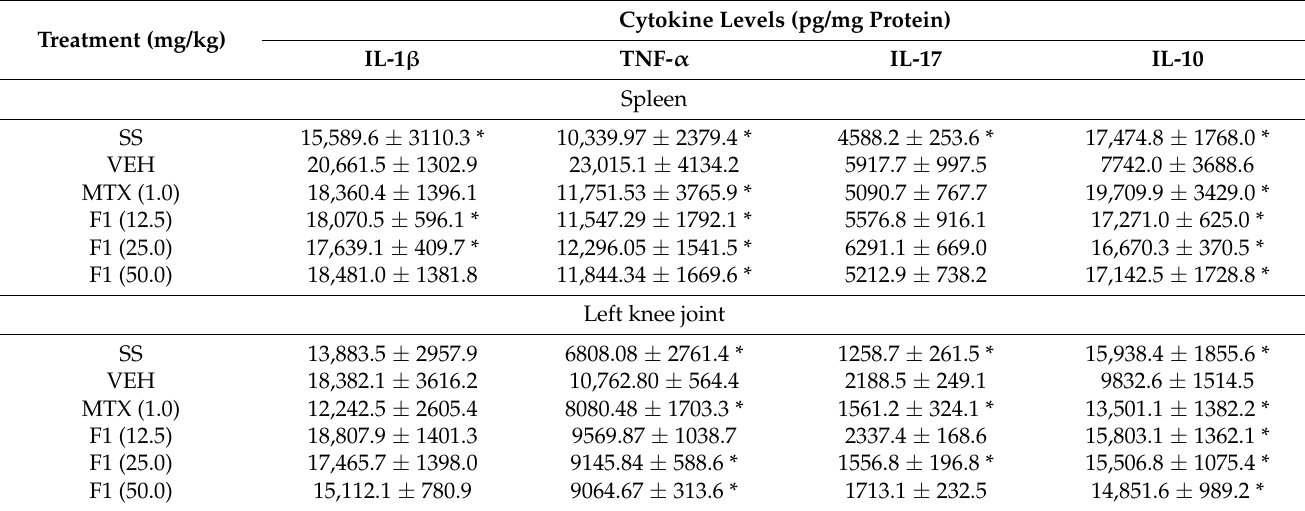
Table 4. Effect of the extract and fractions from A. angustifolia on cytokine levels in spleen and left knee joint in a K/C-induced mono-arthritis model.